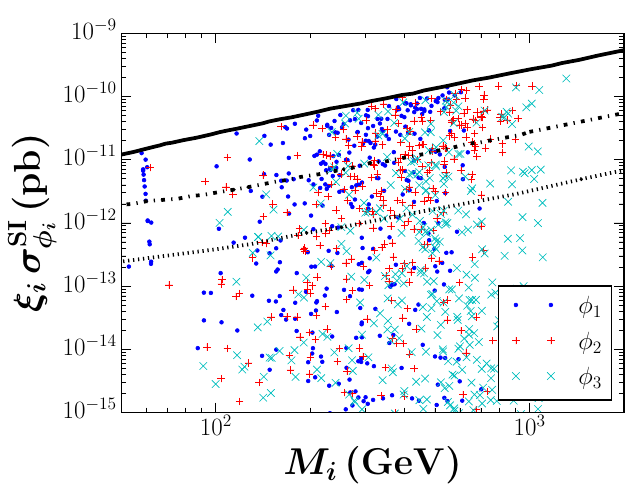
Figure 8 . Detection prospects in the scan with µ S 1 , λ 4 ij 6 = 0 (scan C). The solid line is the current LZ limit whereas the dotted lines correspond to the expected sensitivities of LZ and